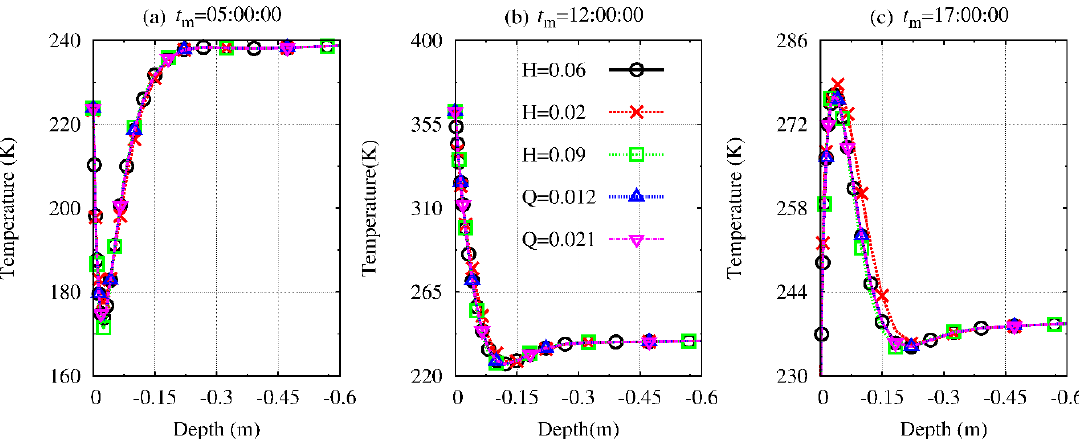
Figure 11. Profiles of temperature–depth for the CE-5 candidate landing site centering at (41.41 ◦ N, 58.53 ◦ W). The panels ( a – c ) represent results at the lunar local time t m = 05:00:00, t m = 12:00:00, and t m =